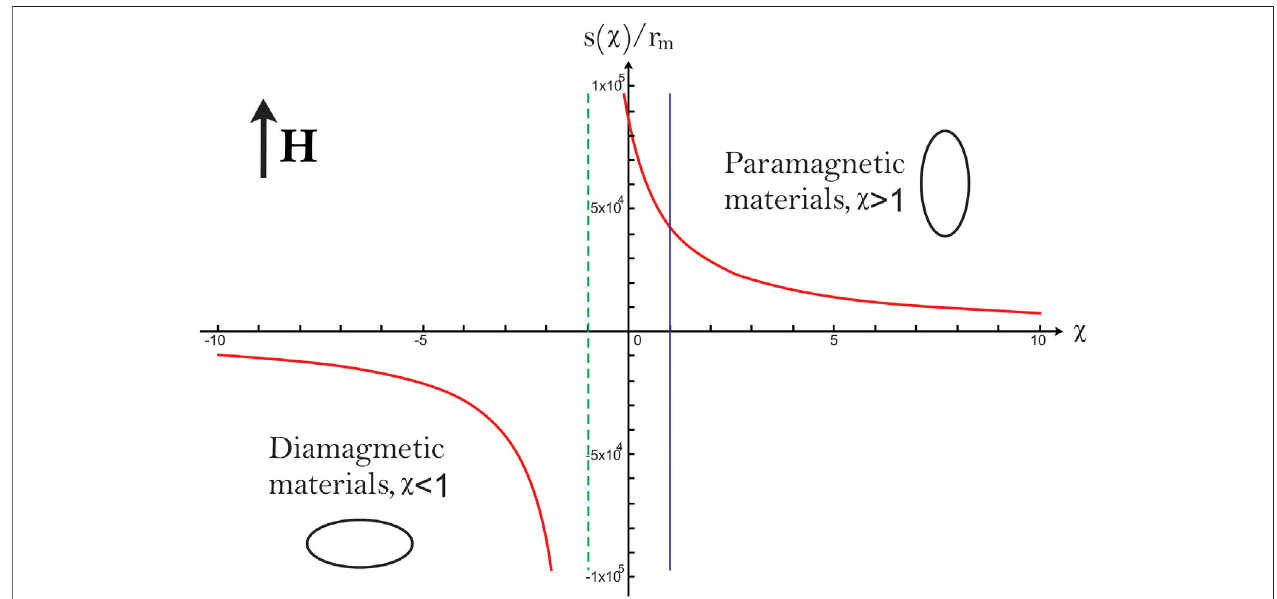
FIGURE7| MorphologicalphasediagramofaMLsinaDCmagnetic fi eld.For μ 1 (cid:1) μ 3 theMLsacquireaprolateshapewhen,themagneticsusceptibility, χ +1 (cid:1) μ 1 / μ (cid:1) μ μ 0 3 / 0 to a diamagnetic material the acquired shape is an oblate. For symmetrical monolayer liposomes, we can assume that c 0 (cid:1) 0 and solutions for the quadratic expressions gives μ 1 (cid:1) 2 μ 2 . For these values of permeability, the deformation can be either oblate or prolate; this line of coexistence is the green dotted line. The blue line is used to distinguish between paramagnetic and diamagnetic